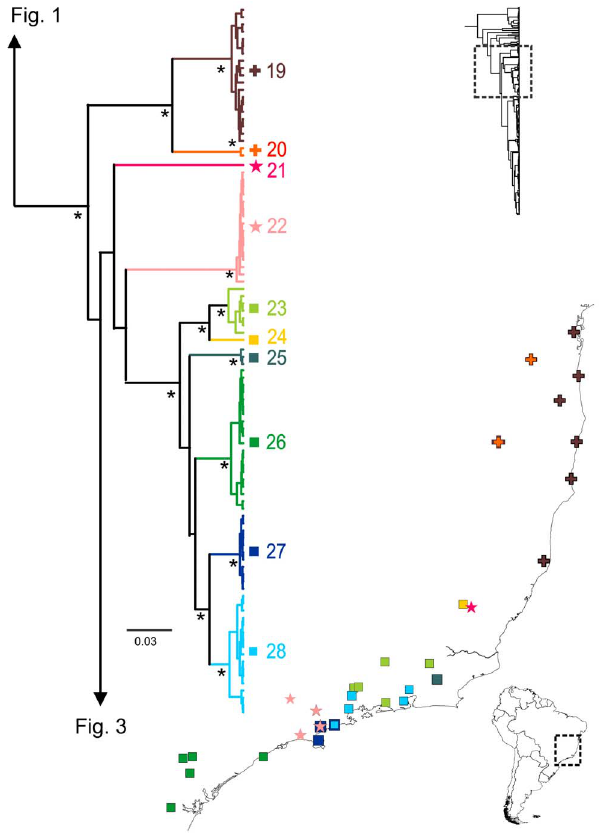
Figure 1. Dendropsophusminutus tree with lineage distribution part 1. 50% Maximum Clade Credibility tree and distribution maps of mtDNA lineages 1–18. Asterisks represent nodes with posterior probability equal to 1. Posterior probabilities lower than 0.9 are not shown.